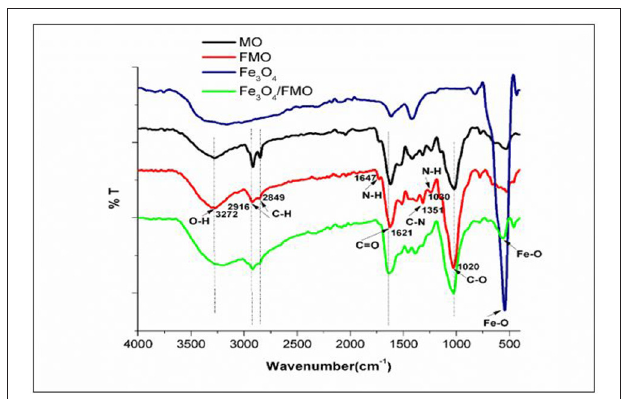
FIGURE 3 | FTIR spectra of MO, FMO, Fe 3 O 4 , and Fe 3 O 4 /FMO.